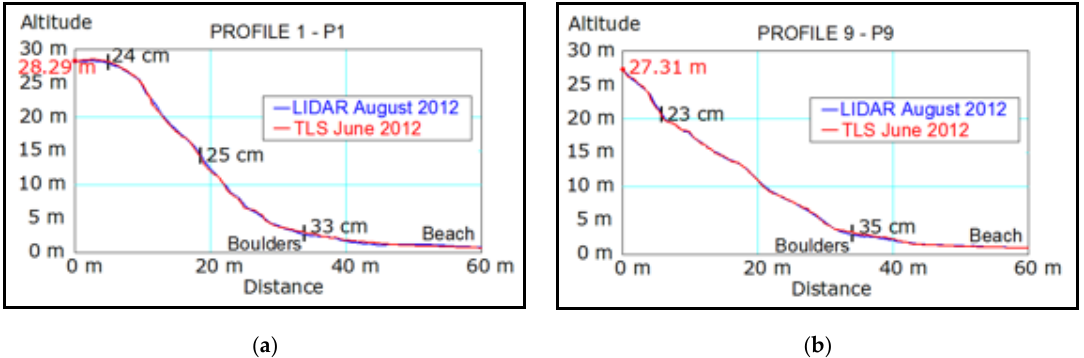
Figure 11. Comparison between the profiles obtained by LiDAR and by TLS (2012). ( a ) Profile 1 (north area of the cliff); ( b ) Profile 9 (south area of the cliff). (north area of the cli ff ); ( b ) Profile 9 (south area of the cli ff ).